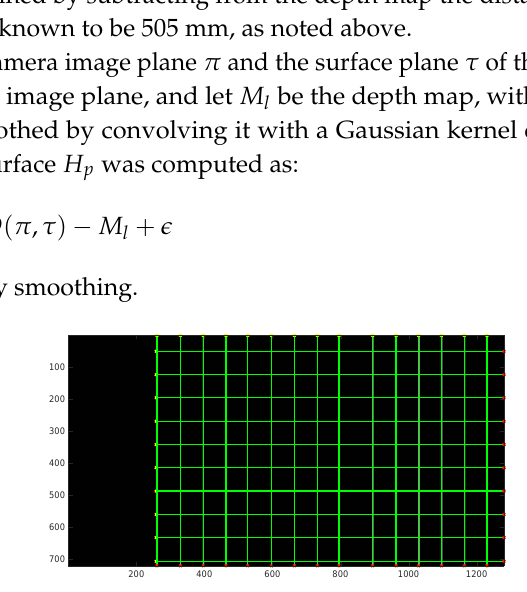
( b ) Lines fitted on the tray cells, with the Hough transform voting.